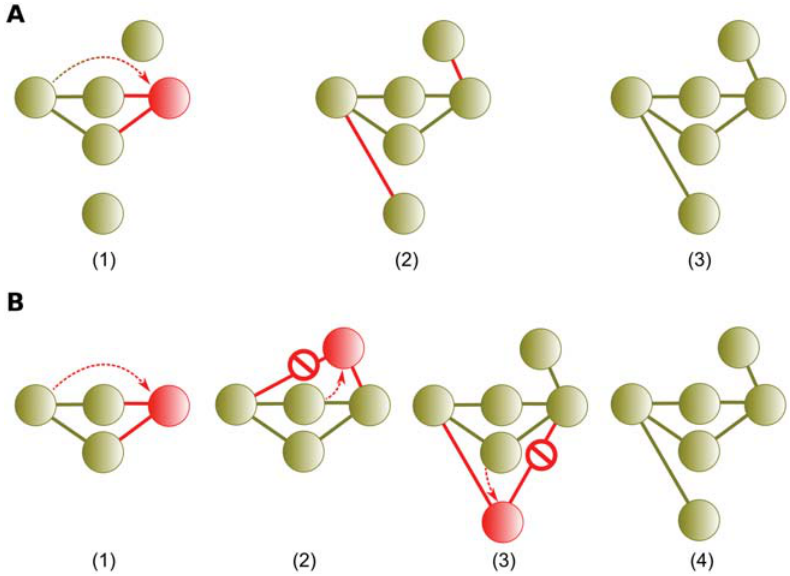
Figure 4. Neofunctionalization vs. concurrent gene duplication and subfunctionalization. (A1) Gene duplication. Shown also are two additional proteins elsewhere in the network. (A2) According to He and Zhang (2005), additional interactions gained by paralogous pairs over time are explained by the formation of de novo interactions. (A3) The resulting network. (B1) Gene duplication. (B2) An interacting partner duplicates, including the loss of a redundant interaction. (B3) Another partner duplicates and loses a redundant interaction. (B4) The resulting network is indistinguishable from that postulated for neofunctionalization.